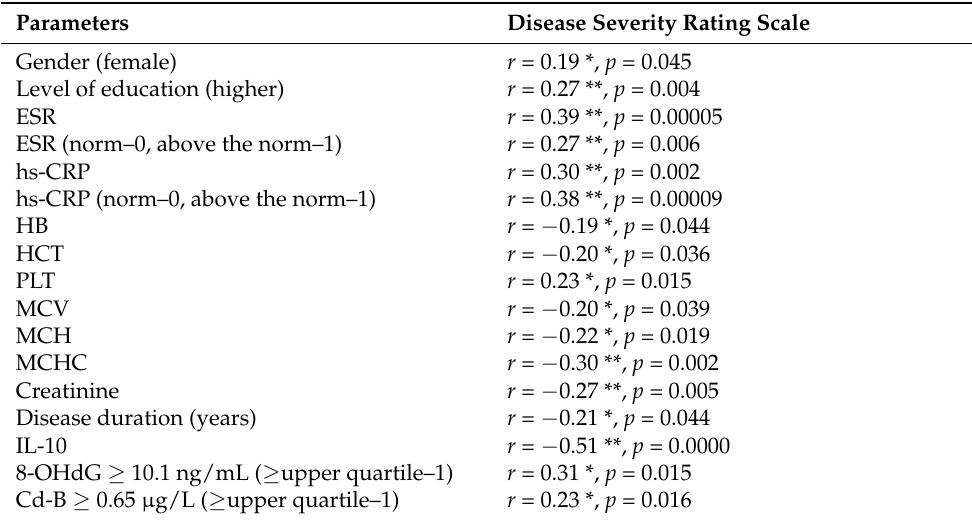
Table 7. Correlations between disease activity (severity of disease scale) and demographic and laboratory parameters in IA